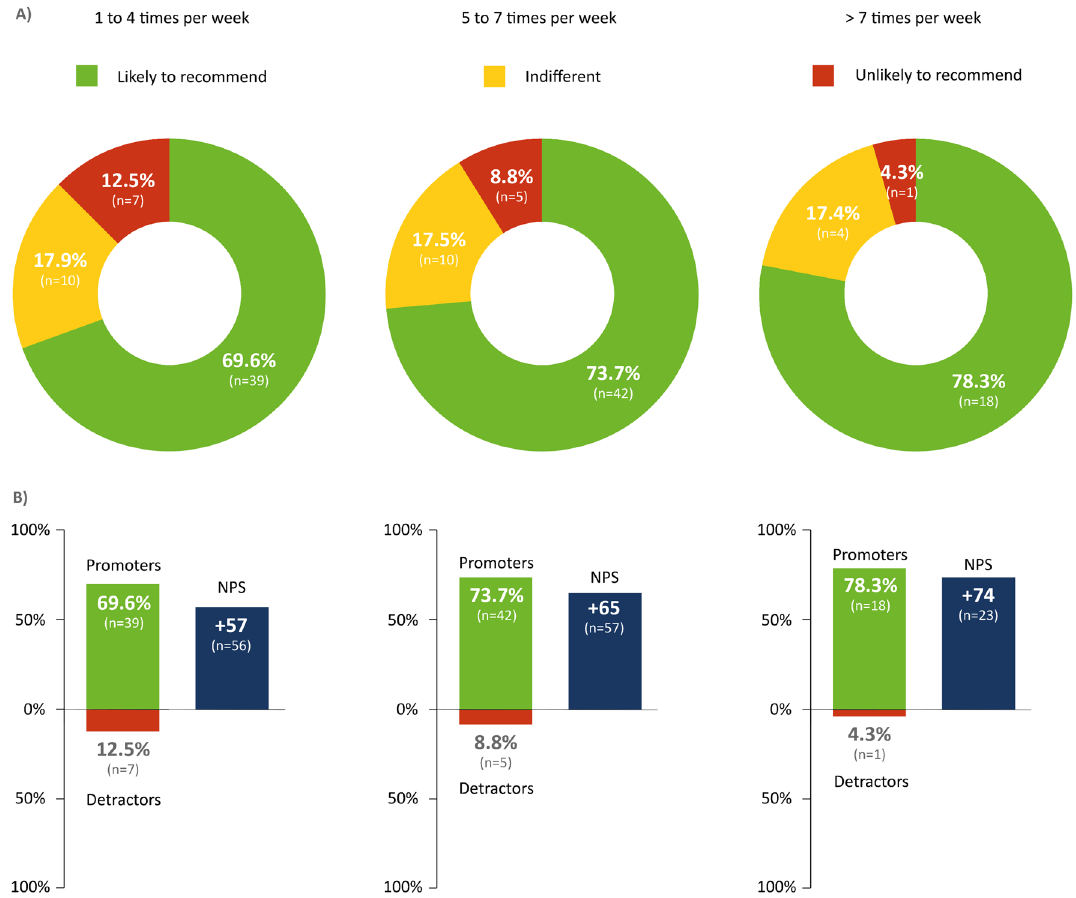
Figure 3. Willingness to recommend the motor-assisted movement exerciser (MME) with respect to frequency of MME use. The NPS was applied to assess participants’ likelihood of recommending the MME. This score was calculated based on responses to a single question: “How likely is it that you would recommend the MME to another friend or patient who is affected with ALS?” Answers were rated between 0 (absolutely unlikely to recommend) and 10 (very likely to recommend). Participants who responded with a score of 9 or 10 were considered “promoters.” Those who scored the treatment between 7 and 8 were considered “indifferent,” and participants who responded with between 0 and 6 points were defined as “detractors” ( A ). The NPS was calculated by subtracting the percentage of detractors from the percentage of promoters ( B ). n = 136; n number of